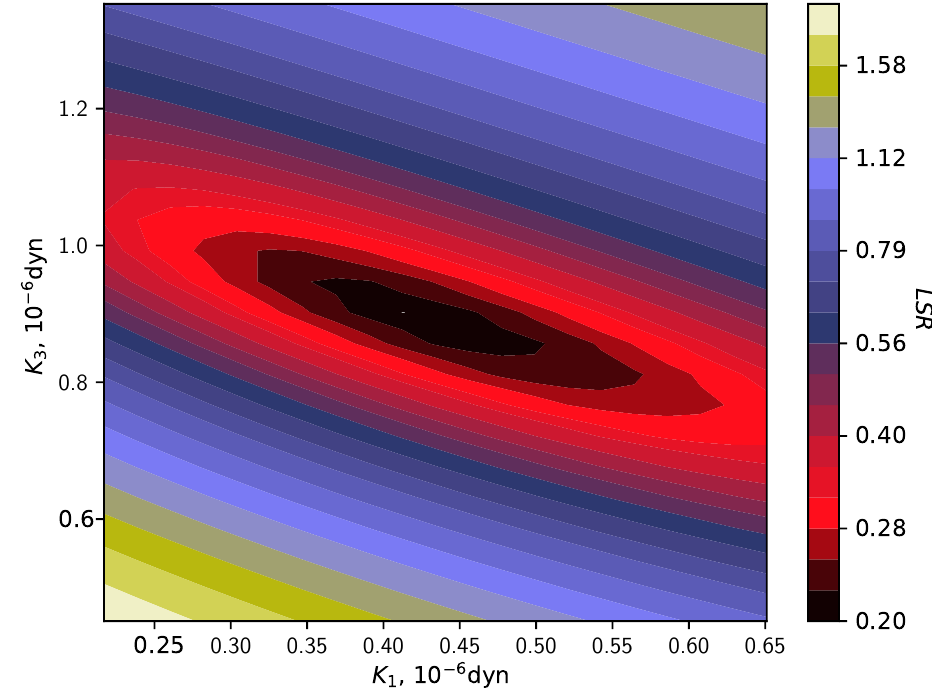
Figure 10. The map for the LSR criterion on K 1 , K 3 for